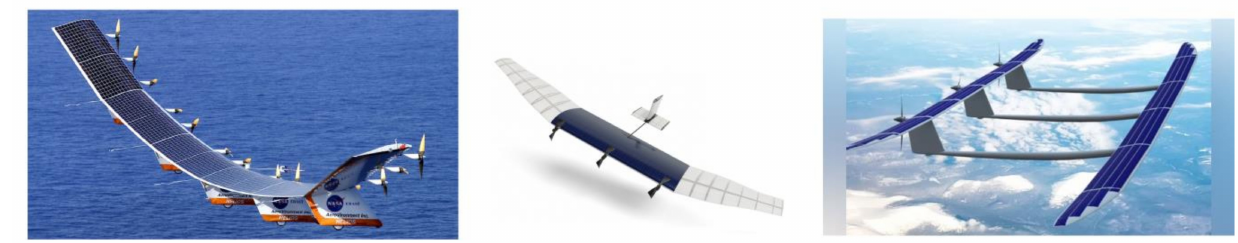
Figure 9. Solar-powered UAVs